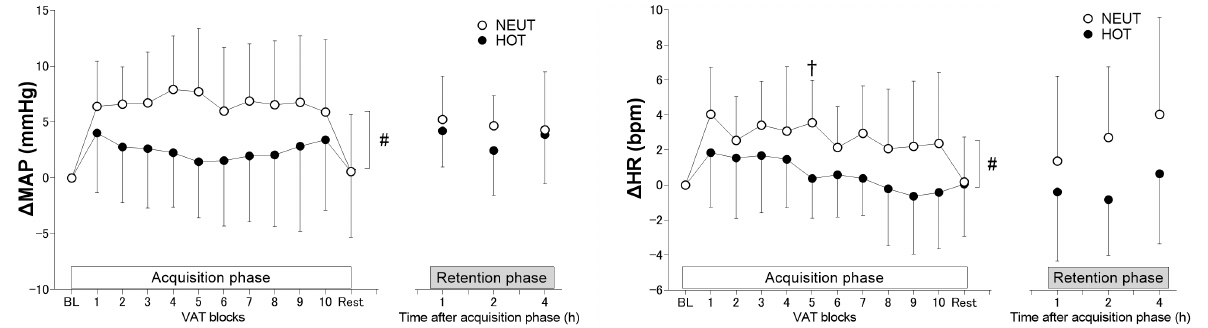
Figure 4. Changes from baseline (BL) before each VAT trial in mean arterial pressure ( ∆ MAP) and heart rate ( ∆ HR) during VAT tasks in thermoneutral (NEUT, n = 13) and hot (HOT, n = 15) environments for acquisition (left panel) and retention (right panel) phases. Values are presented as means ± SD. #, the main effect of environmental condition, all p ≤ 0.038. †, NEUT vs. HOT at each block ( p = 0.017).